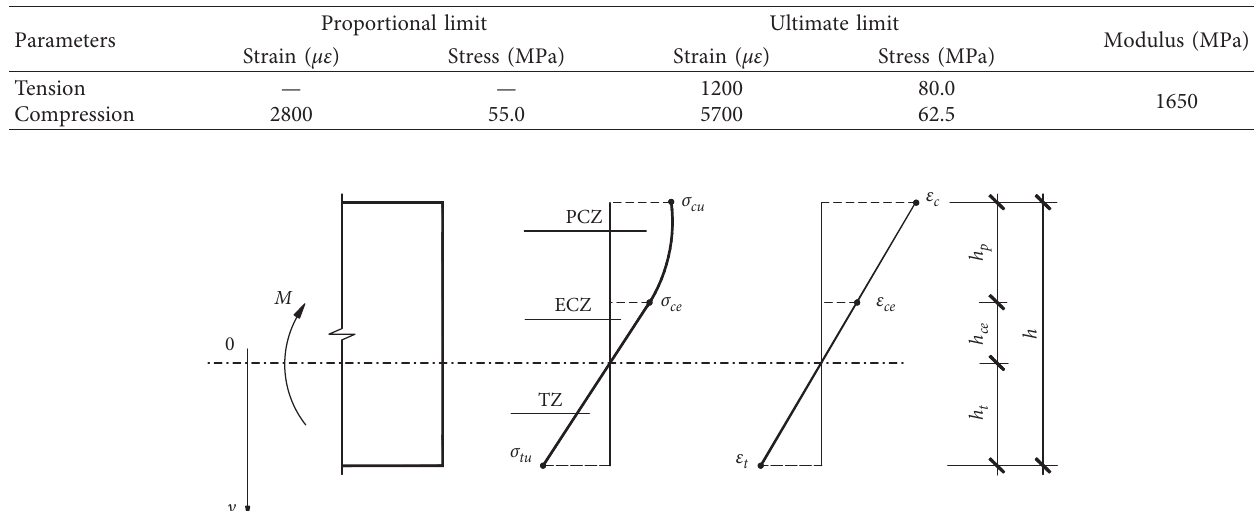
Table 1: Mechanical parameters of the PSL specimen.